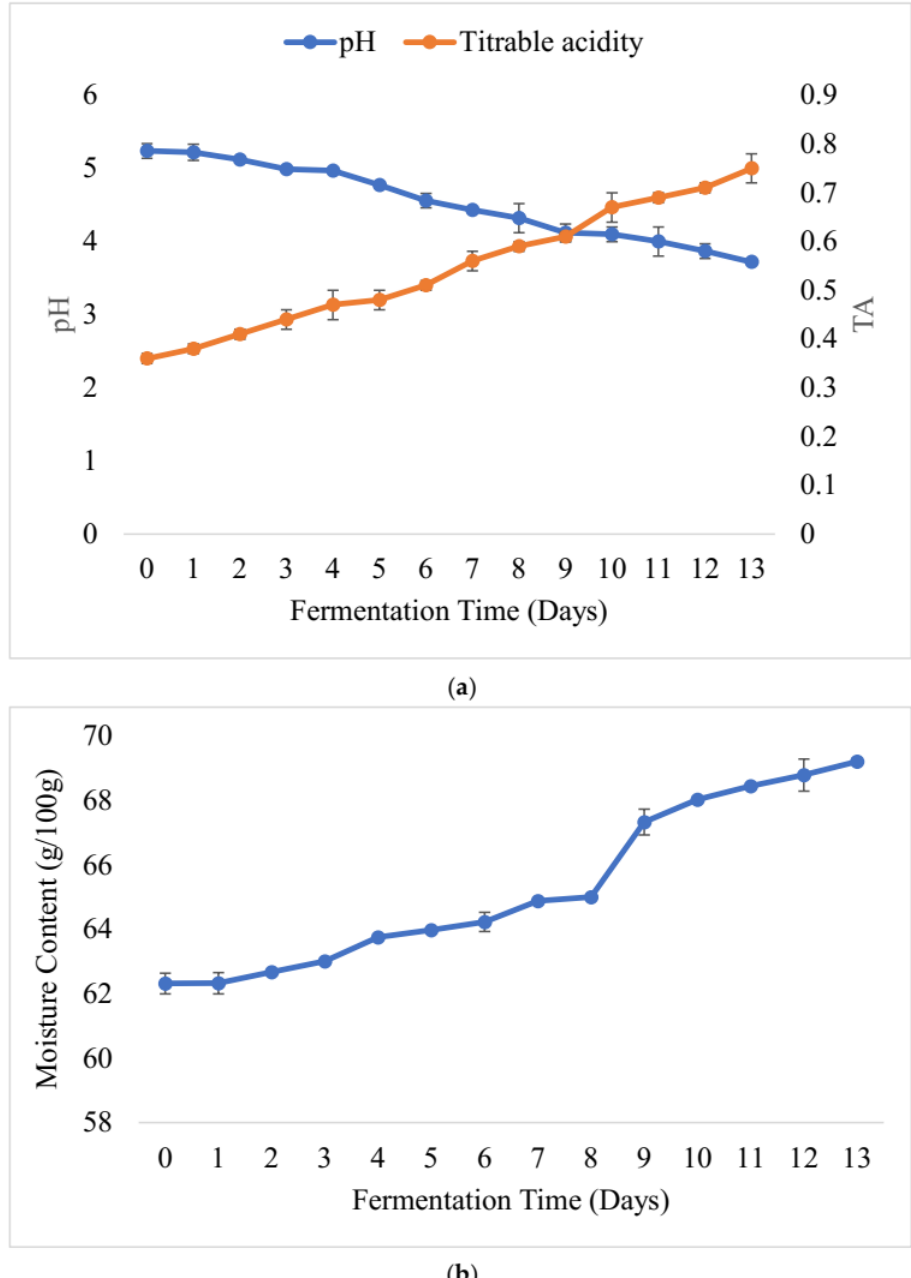
Figure 5. pH and TA values ( a ) and moisture content ( b ) of laboratory-prepared maize-based Shameta. The mean counts of Enterobacteriaceae and total coliforms (TC) increased for the first two days of fermentation. Then, there were gradual declines in counts before their total elimination from the fermentation system on the 7th and 6th days of fermentation, respec- tively (Figure 6). The elimination of Enterobacteriaceae and TC might have been due to the drop in pH, the inhibitory effects of essential oils in spices and production of other antimicrobial metabolites by lactic acid bacteria [12]. Accordingly, Enterobacteriaceae dis- appeared from the fermenting Shameta when the pH further dropped to 4.3, the result that corroborated an earlier report [60] that revealed the observation that Enterobacteriaceae cannot grow between pH 3.5 and 4.0. An early drop in the mean counts of pathogenic microorganisms (including members of Enterobacteriaceae and coliforms) leading to ultimate elimination from the fermenting product at the end of fermentation is advantageous